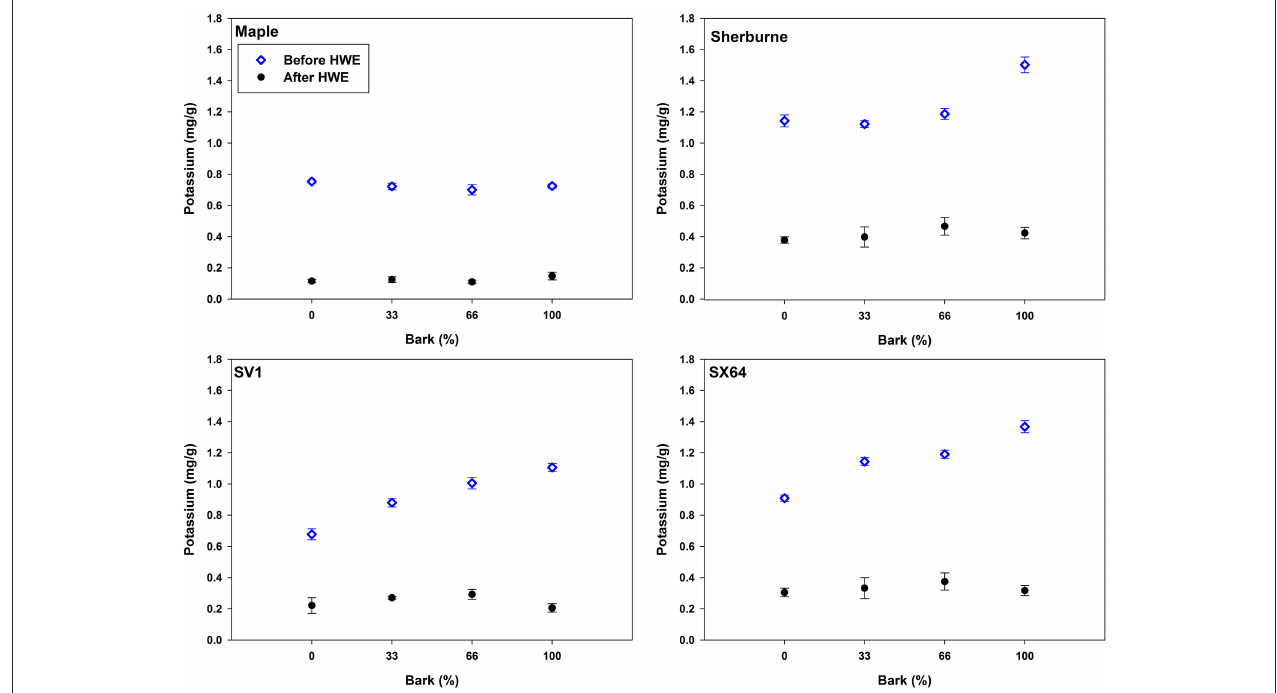
FIGURE 3 | Potassium content of sugar maple and three willow cultivars with bark levels ranging from 0 to 100% before and after HWE (errors bars represent standard deviations).